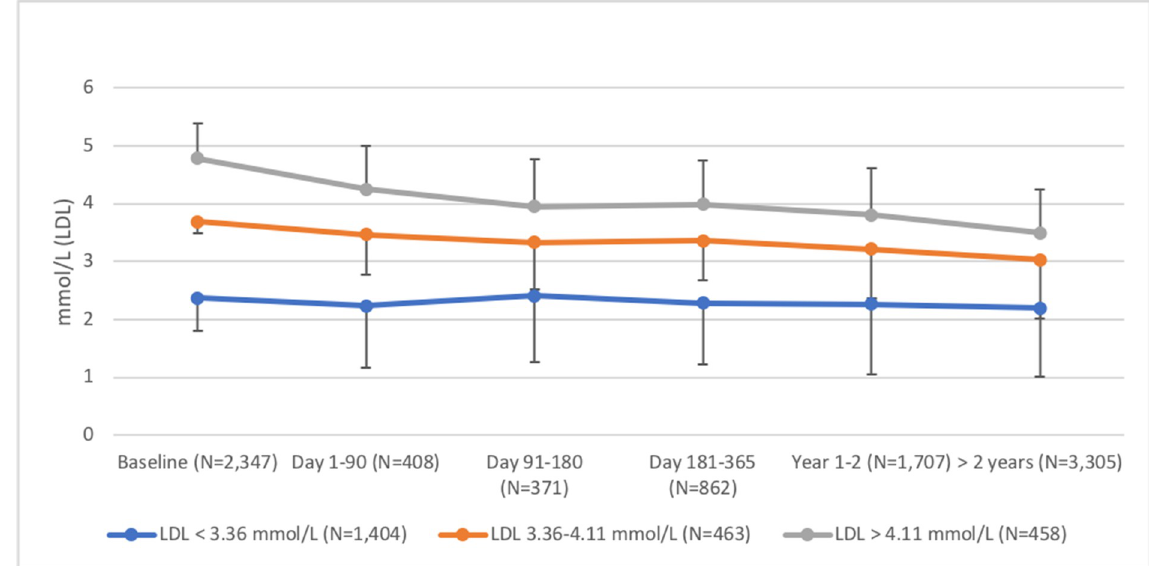
Fig 8. Changes in low-density lipoprotein (LDL)–cholesterol levels after the baseline examination in Healthy Ageing Initiative (HAI) participants, based on LDL-cholesterol at baseline. The figure is based on a total of 6,631 measurements in 2,347 HAI participants. Participants were categorized in 3 groups based on LDL-cholesterol level at baseline: optimal ( < 3.36 mmol/l, blue line), intermediate (3.36– 4.11 mmol/l, orange line), and high ( > 4.11 mmol/l, gray line). Means and standard deviations are